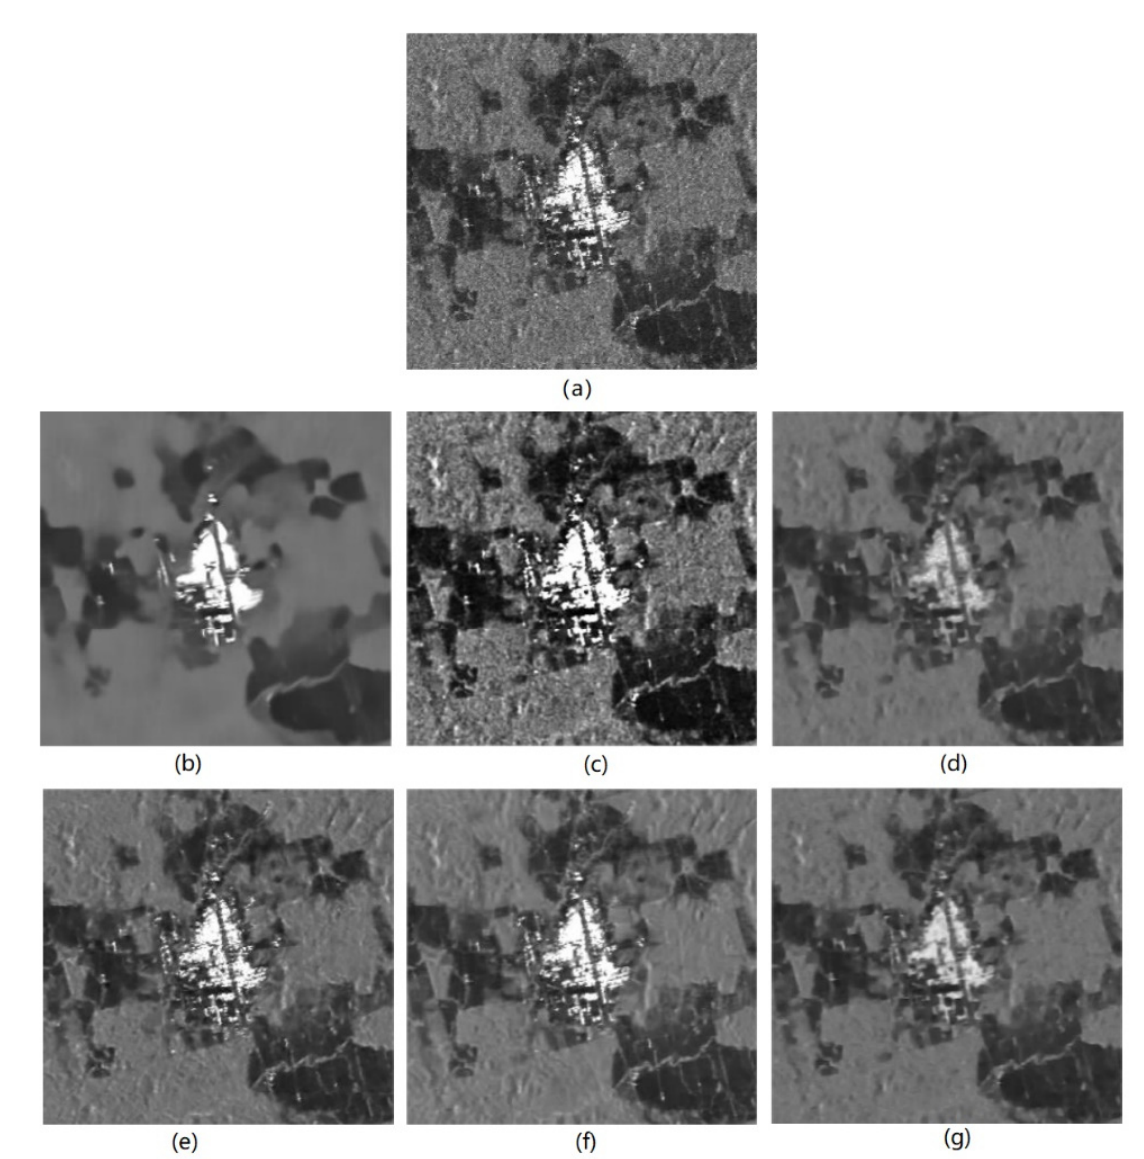
Figure 5. The despeckling result of the ALOS dataset. ( a ) Speckled image. ( b – g ) The images filtered by the PPB filter, the SAR-DRN filter, the BM-NR-DL filter trained with one image, the NR-SAR-DL filter, the MSAR-BM3D filter, and the BM-NR-DL filter trained with bi-temporal images, respec- tively.